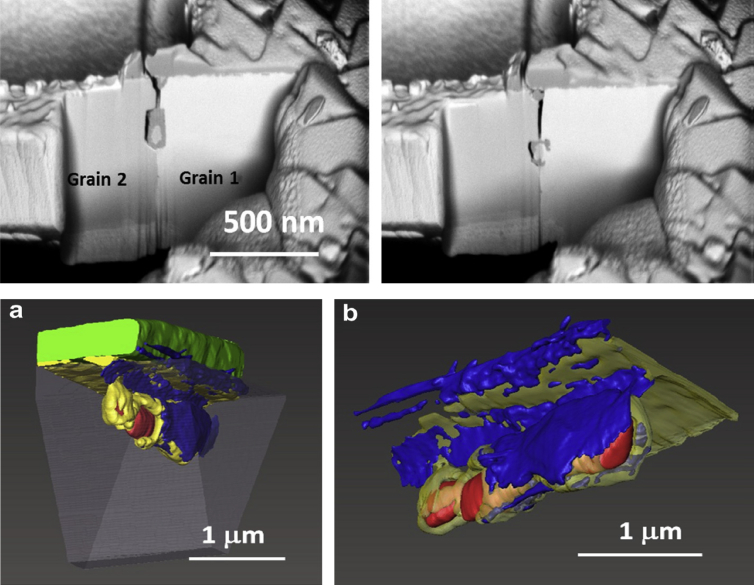
Secondary electron images obtained during FIB serial sectioning of a triangular profile micro-cantilever following exposure to PWR conditions and loading. From Dugdale et al. [2013].43